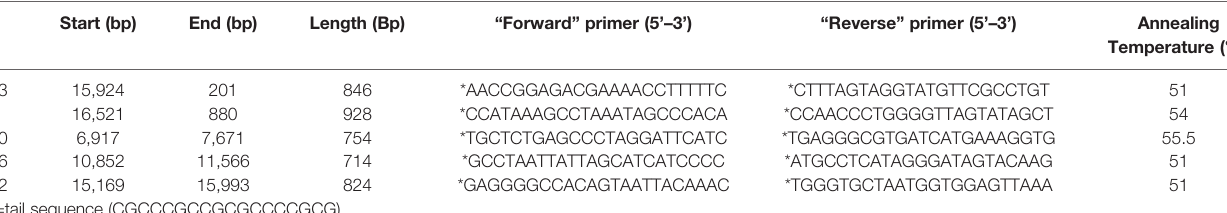
TABLE 1 | First round mitochondrial speci fi c primer pairs resulting in ampli fi cation product between 714 and 928 base pair in